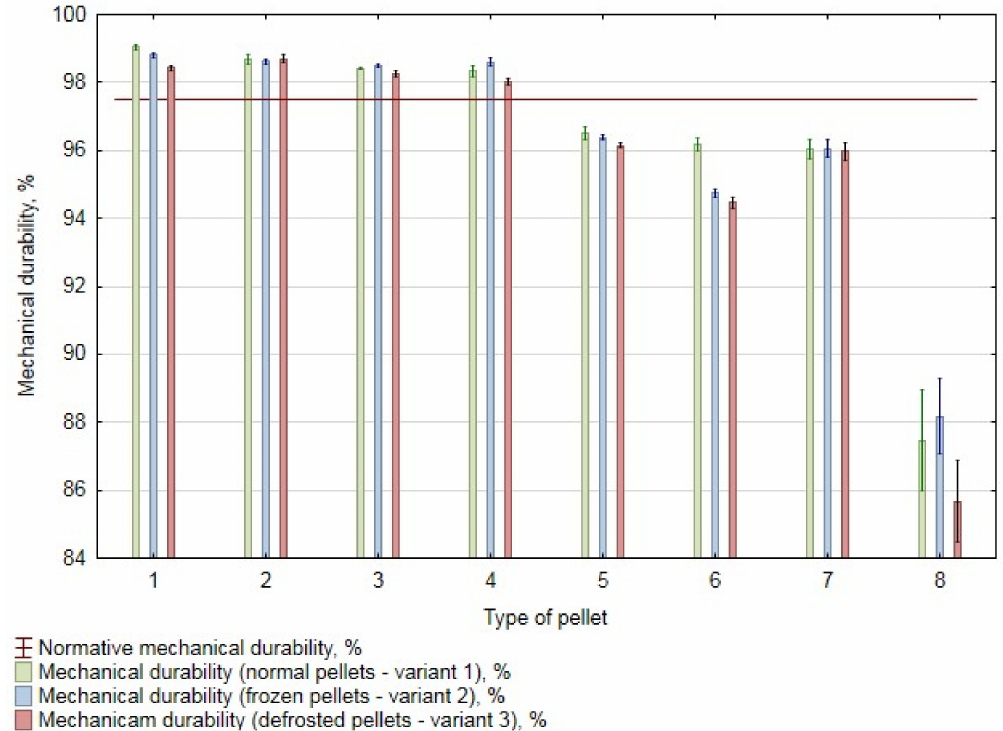
Figure 4. Mechanical durability of commercial pellets from biomass in three storage conditions: (1) Digestate pellet, (2) Pine sawdust pellet, (3) Wheat straw pellet, (4) Post-hydrolytic wood pellet, (5) Agricultural residues pellet, (6) Mix of fine coal (45%) and straw (55%), (7) Corn settlements pellet, (8) Sunflower husk